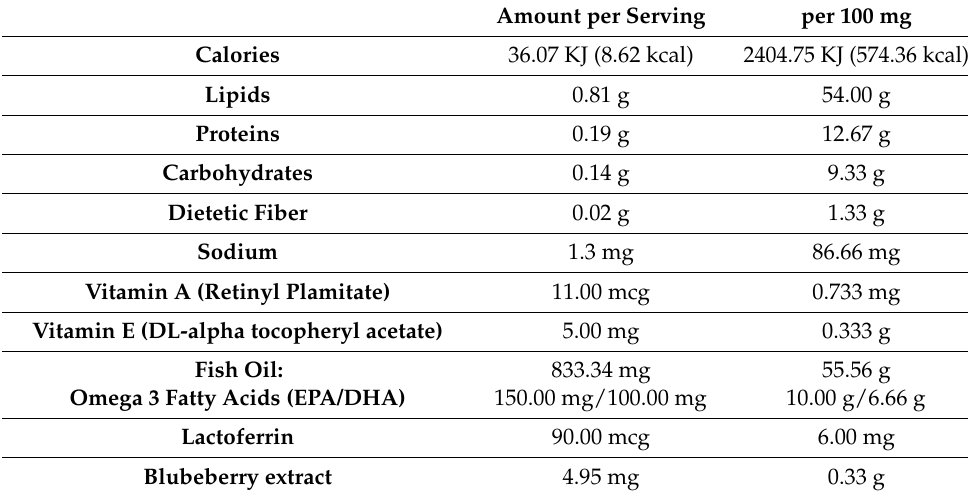
Table 1. Study formulation facts.